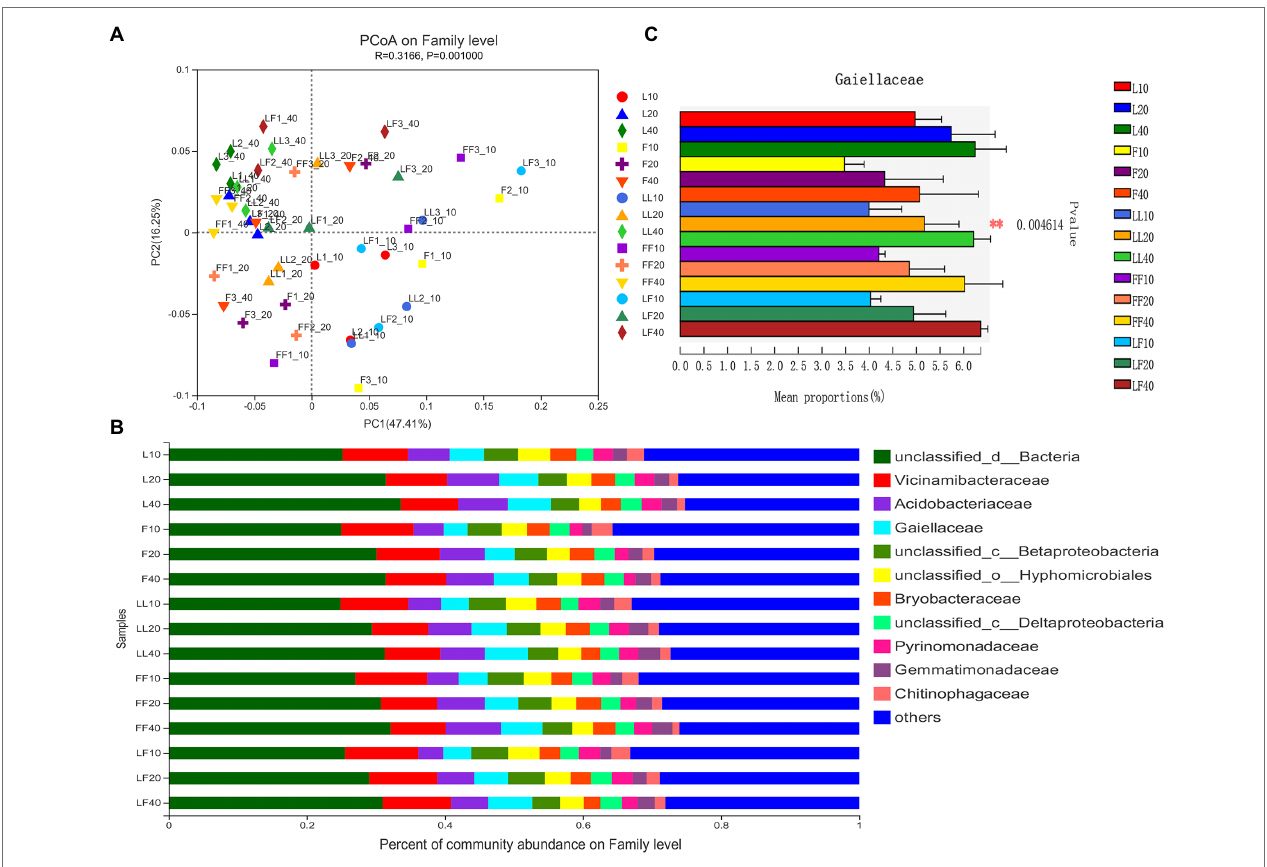
FIGURE 3 | Bacterial community composition in different soil samples. (A) Principal coordinates analysis of bacterial community composition. (B) Bacterial community structure at the level of family. (C) The results of Kruskal–Wallis H test on the difference of Gaiellaceae in different soil samples. Refer to Figure 1 legend for relevant